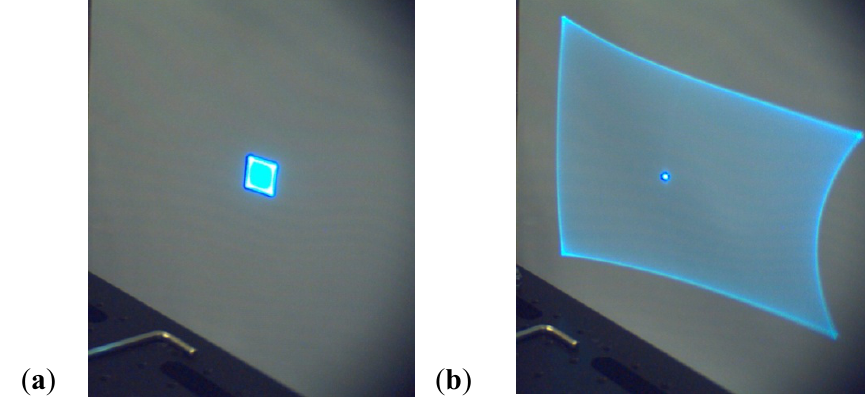
Figure 7. ( a ) Biaxially scanned laser beam based on a MEMS mirror actuated at atmosphere with 40 V applied to fast axis (17.8 kHz), 5 V applied to slow axis (0.5 kHz); ( b ) Biaxially scanned laser beam based on identical but vacuum packaged MEMS mirror design at identical driving voltages of 40 V applied to fast axis, 5 V applied to slow axis.